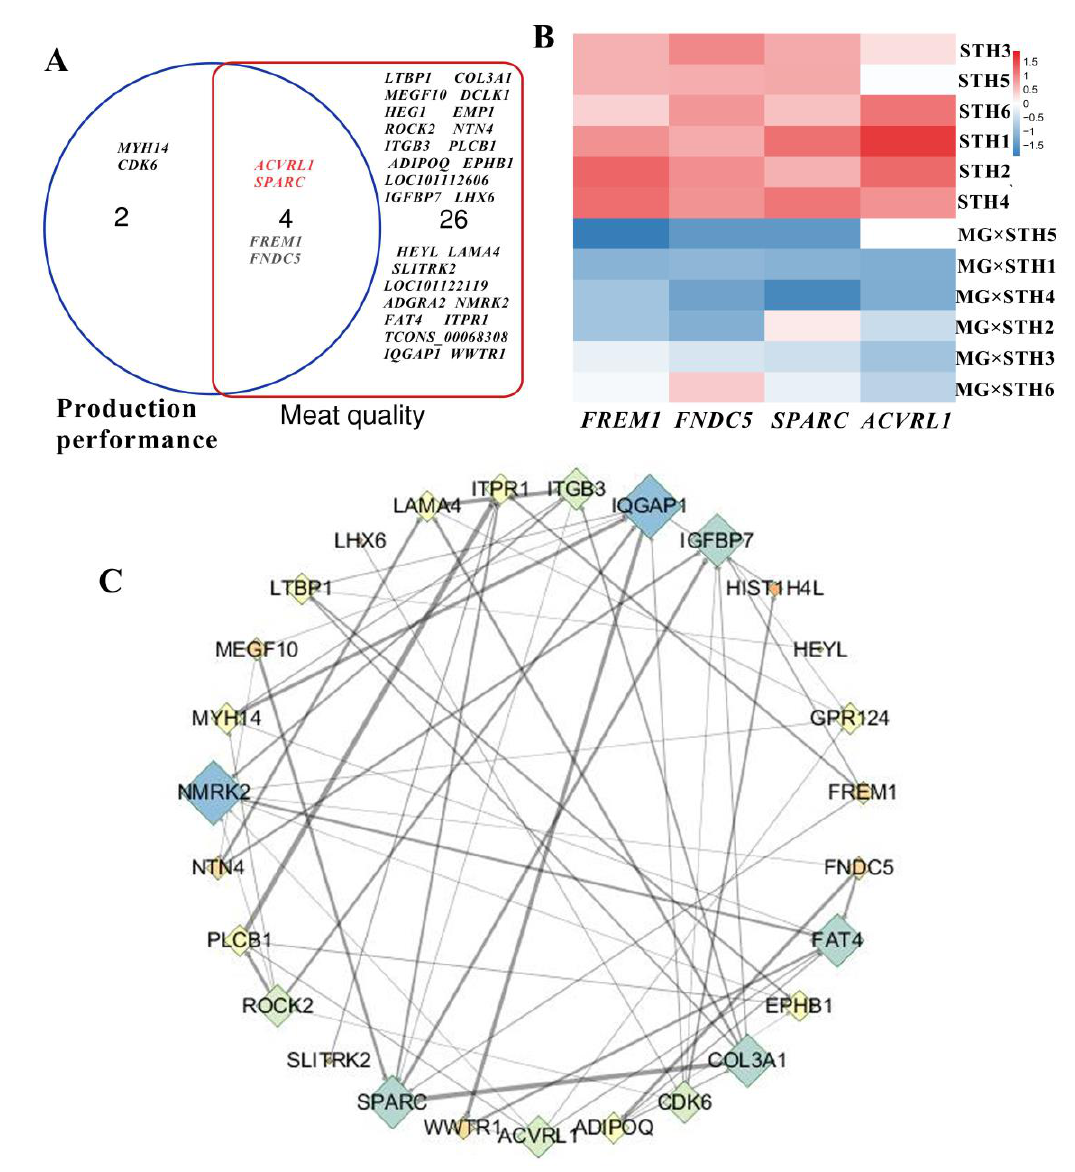
Figure 5. Gene co-expression analyses of targeted DEGs related to sheep production performance and meat quality. ( A ) A Venn diagram of DEGs with Pearson correlation coe ffi cient thresholds > 0.75 or < − 0.75 related to production performance and meat quality. ( B ) A heatmap of four DEGs related both to production performance and to meat quality. ( C ) The gene co-expression network of targeted DEGs ( > 0.75 or < − 0.75) related to sheep production performance and meat quality.